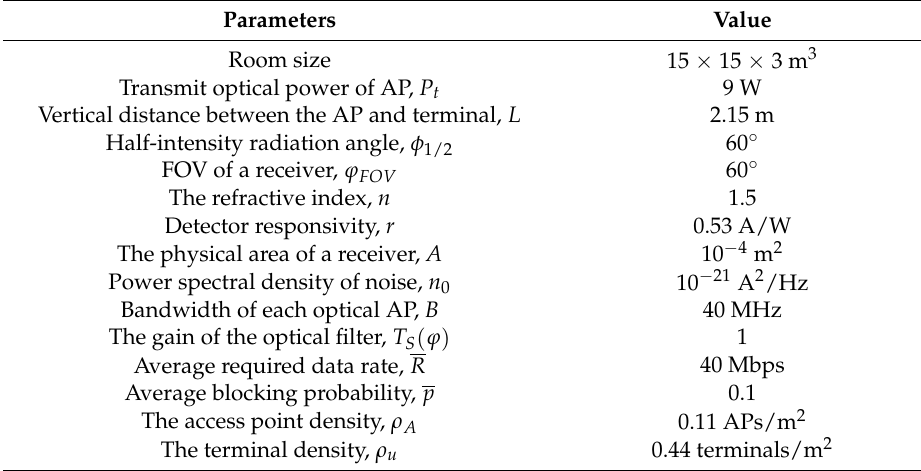
Table 1. Simulation